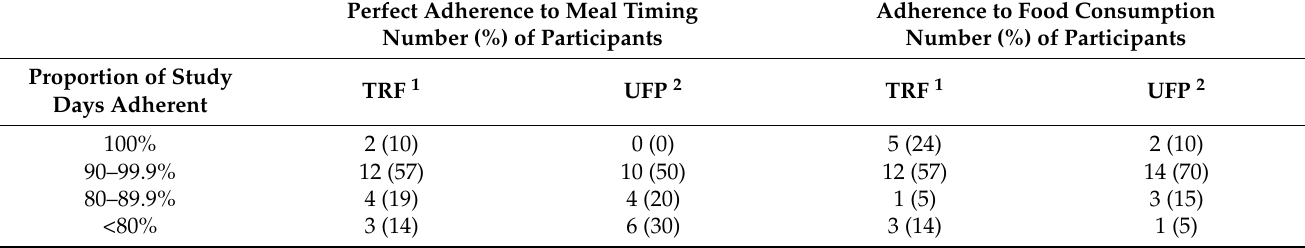
Table A2. Perfect adherence to meal timing and food consumption on the per participant level by study